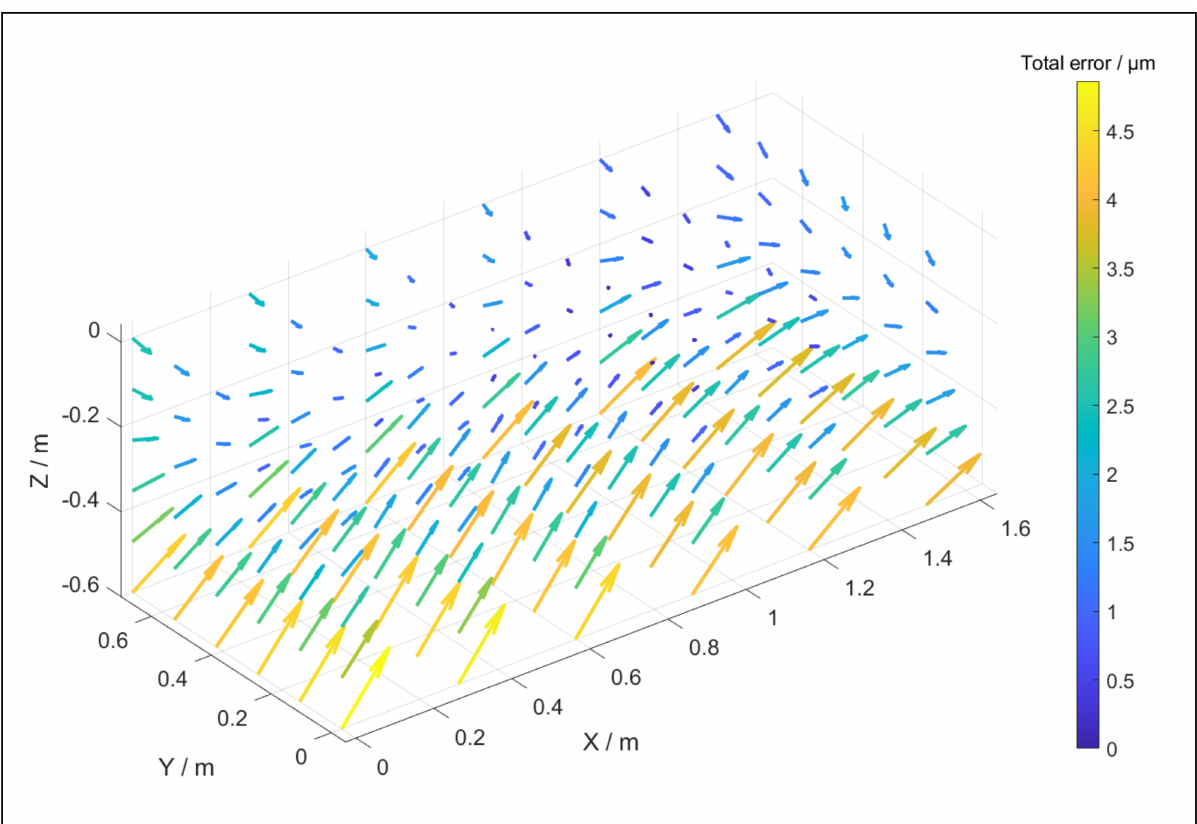
Figure 4. An example of the total error of the phmp in the coordinate system of a virtual CMM. The error components of this virtual CMM are depicted in Figures 3 and